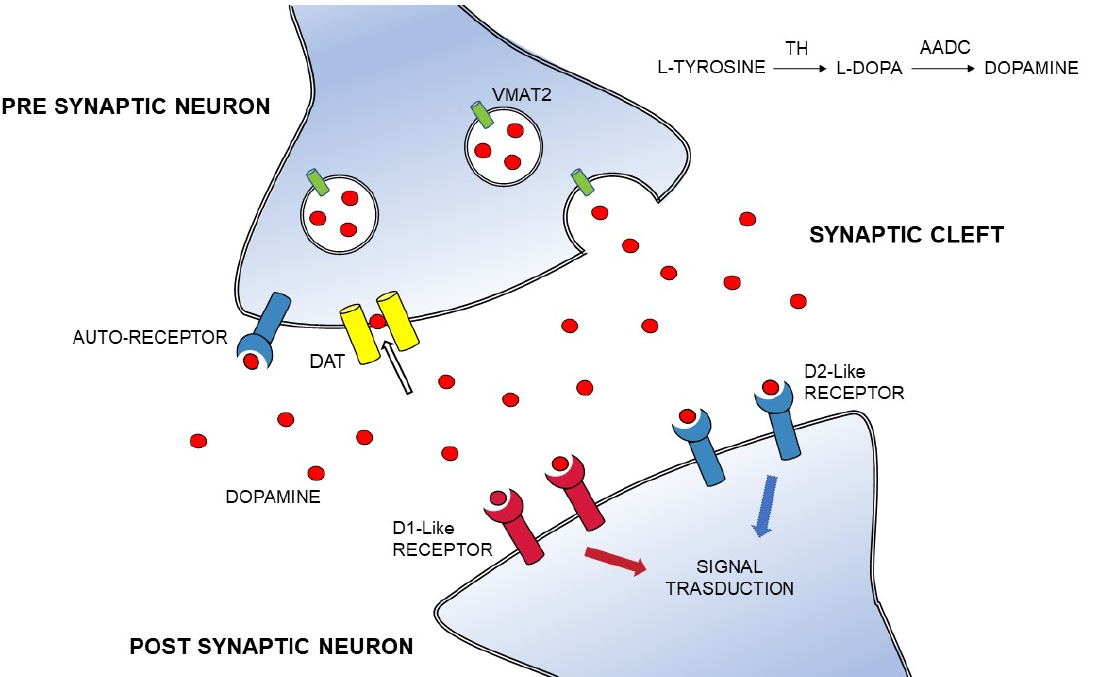
Figure 1. The dopaminergic synapse. DA is derived from the L-tyrosine metabolism to L-dopa mediated by TH and AADS; the DA transport into synaptic vesicles is operated by VMAT-2; the DA synthesis is regulated via presynaptic auto-receptors (in blue); the presynaptic neuron releases DA (red circles); DA binds two main types of receptors (D1 family formed by D1-D5 receptors and D2 family formed by D2-D3-D4 receptors) on the post-synaptic neuron; presynaptic DAT (in yellow) regulates the DA reuptake from the extracellular fluid. Abbreviations: DA, Dopamine; AADC, aromatic L-amino acid decarboxylase; DAT, dopamine transporter; TH, tyrosine hydroxylase; VMAT-2, vesicular monoamine transporter 2.